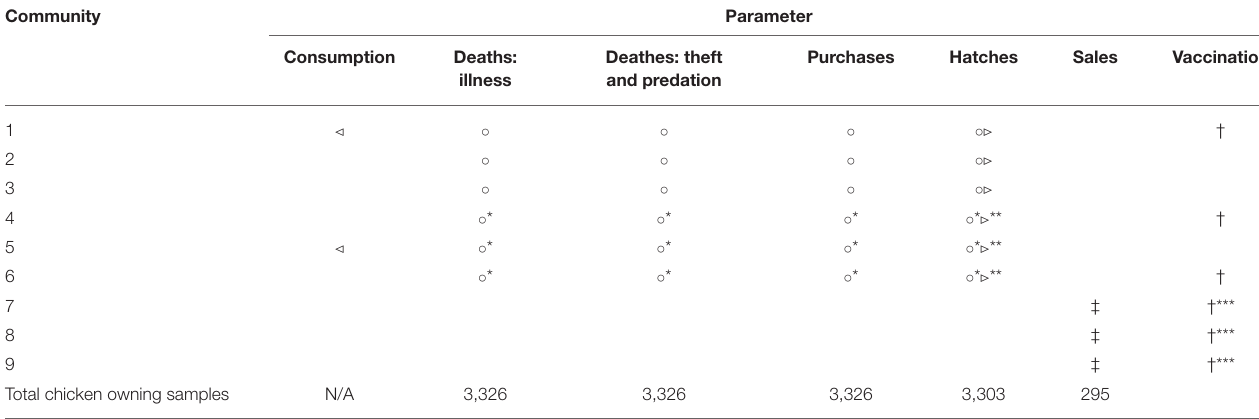
TABLE 1 | A tabular representation of where, when and what data was utilized. Community Parameter Consumption Deaths: Deathes: theft illness and predation